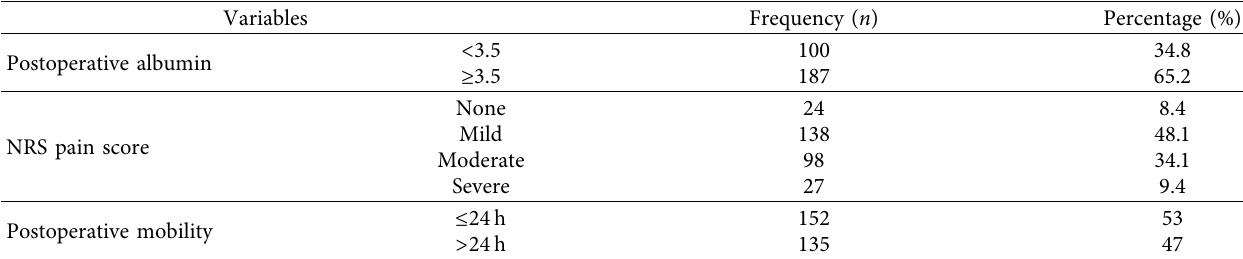
The values are expressed in numbers and